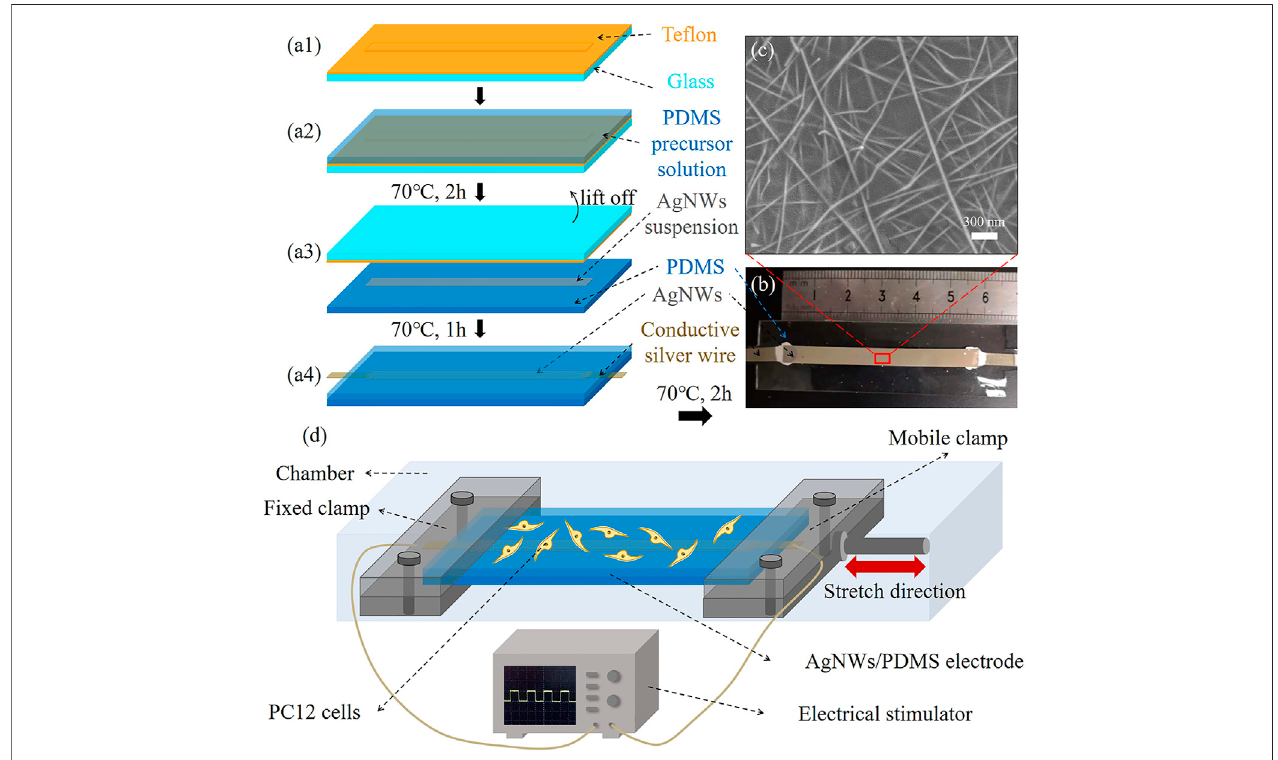
FIGURE1|(A) FabricationprocedureoftheAgNWs/PDMSelectrodepreparation. (B) PhotographofthepreparedAgNWs/PDMSelectrode. (C) SEMimageofthe surface of the AgNWs layer in the AgNWs/PDMS electrode. (D) Schematic illustration of electromechanical